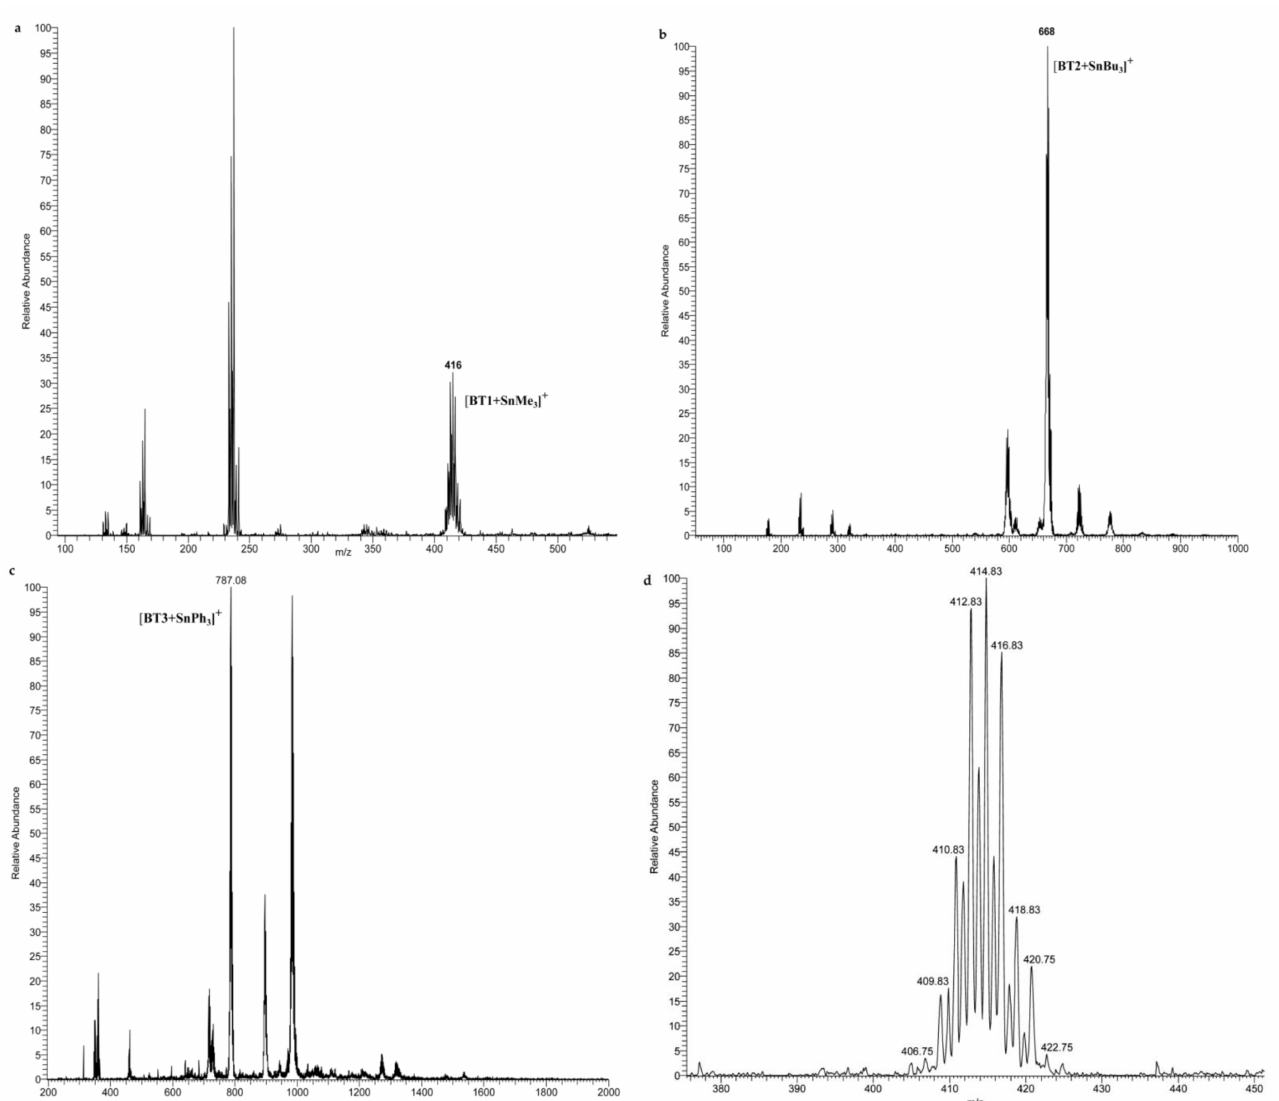
Figure 2. Positive full scan spectra of BT1 ( a ); BT2 ( b ); BT3 ( c ); Compounds and zoom scan spectrum of m / z 416 [BT1+SnMe 3 ] + ( d